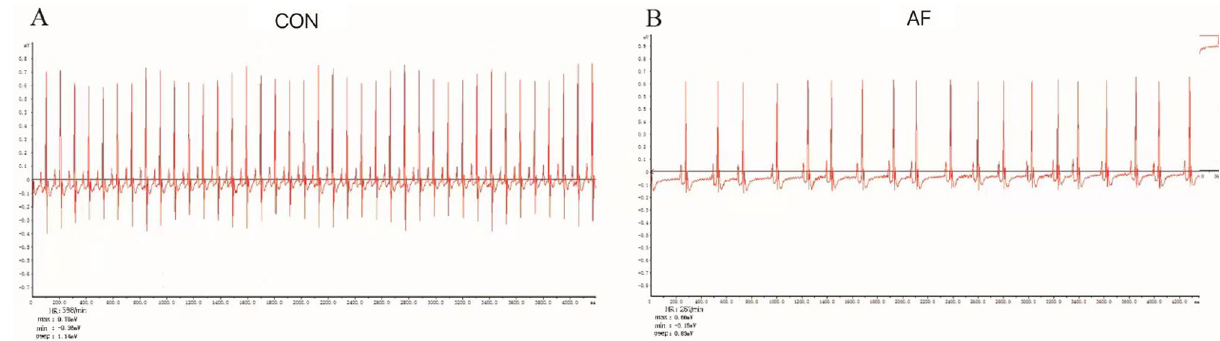
Figure 2. The feature of ECG waveform in two mice groups. ( A ) The feature of ECG waveform in CON mouse. ( B ) The feature of ECG waveform in AF